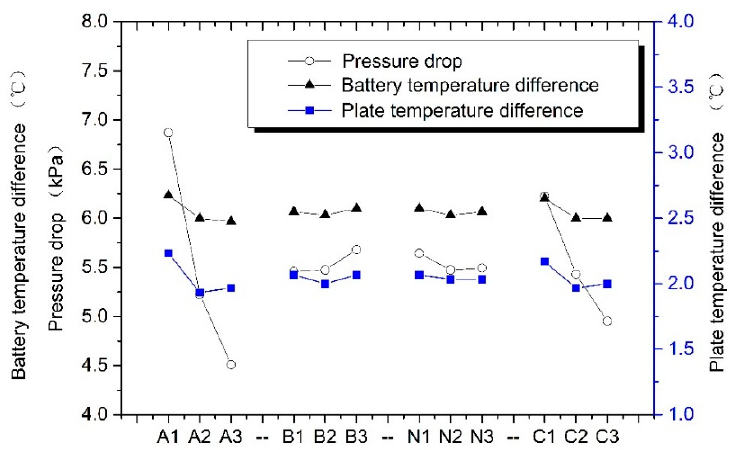
Figure 11. Effect of factors in different levels on indexes.